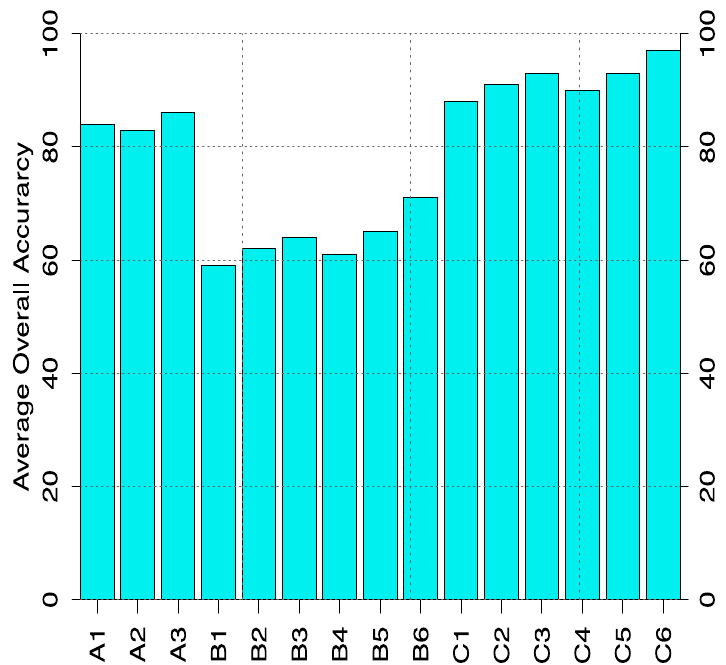
Figure 7. Comparison of the overall classification accuracy achieved on different data categories based on the validation samples.